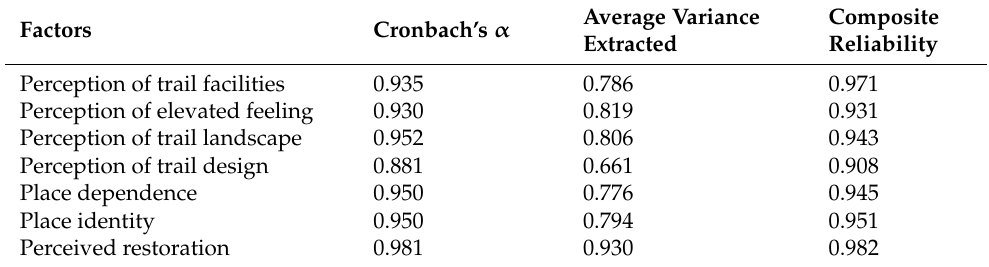
Table 3. Confirmatory factor analysis.